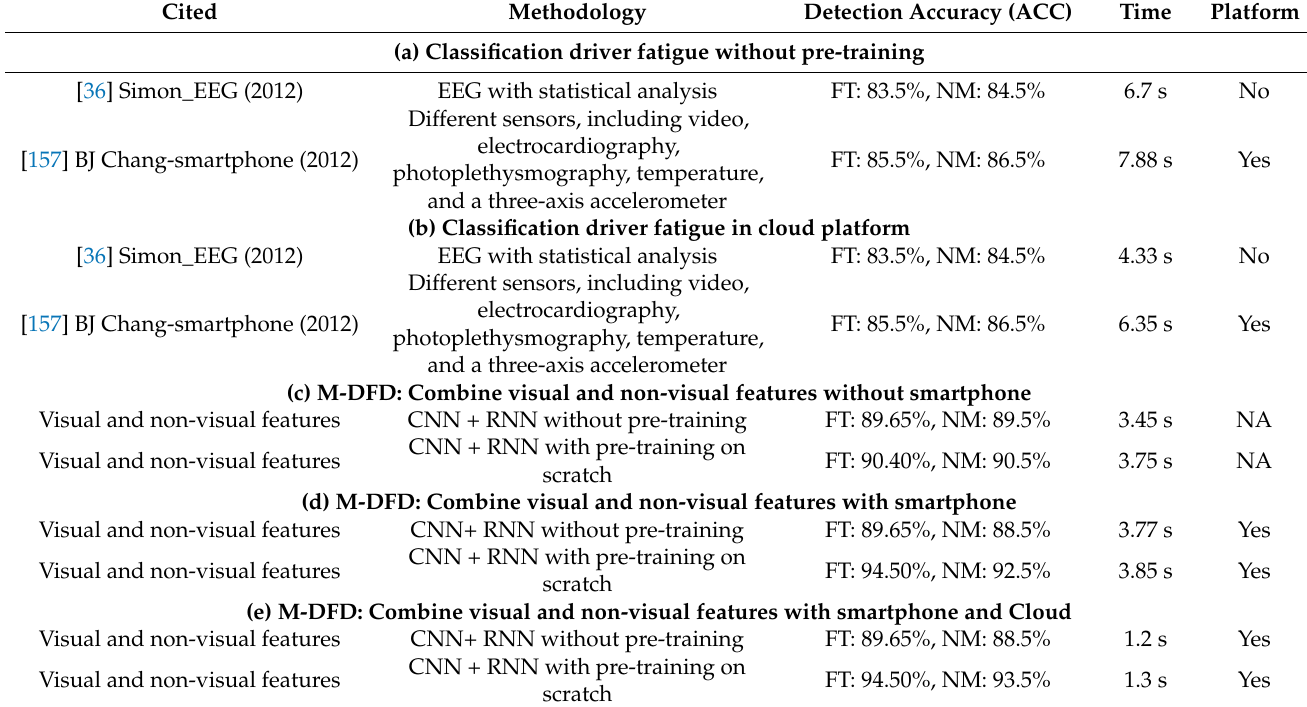
Table 9. Comparisons to state-of-the-art driver’s fatigue detection systems, in terms of multimodal (visual and non-visual); these com- parisons are based on two-stage classification DFD systems, such as normal- and fatigue-based on 10 subjects under normal conditions.